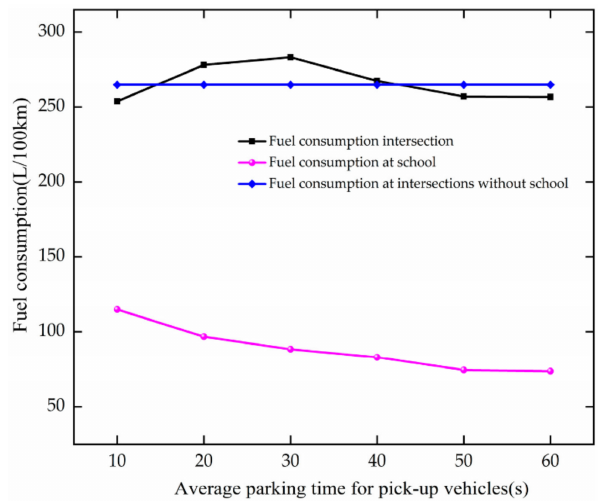
Figure 31. Variation trend of fuel consumption with APT.